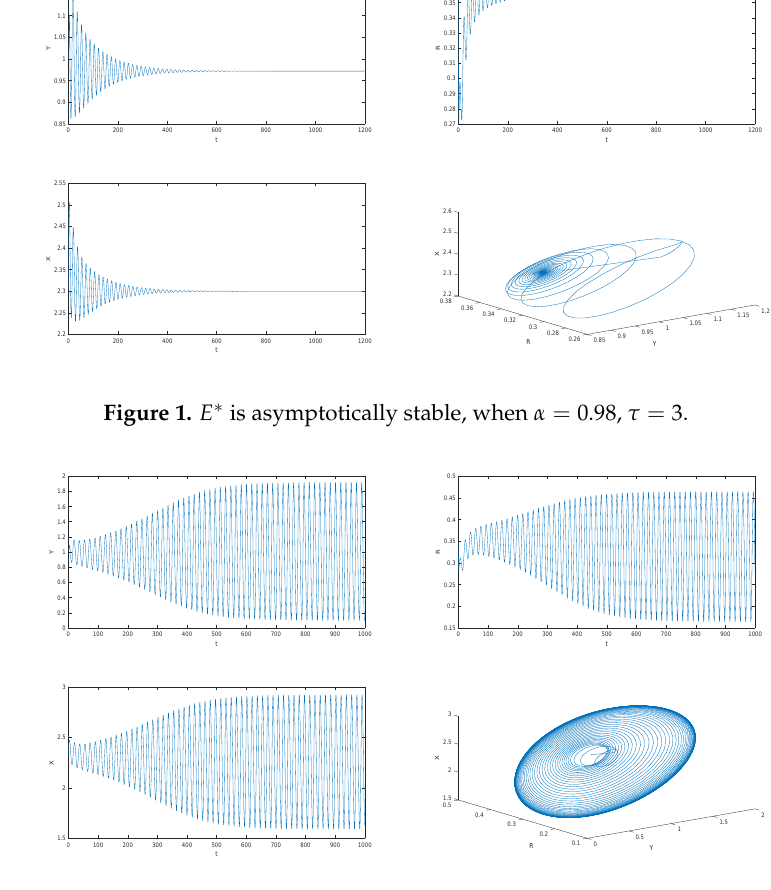
Figure 2. Stable periodic orbit of System (28), when α = 0.98, τ = 3.2.